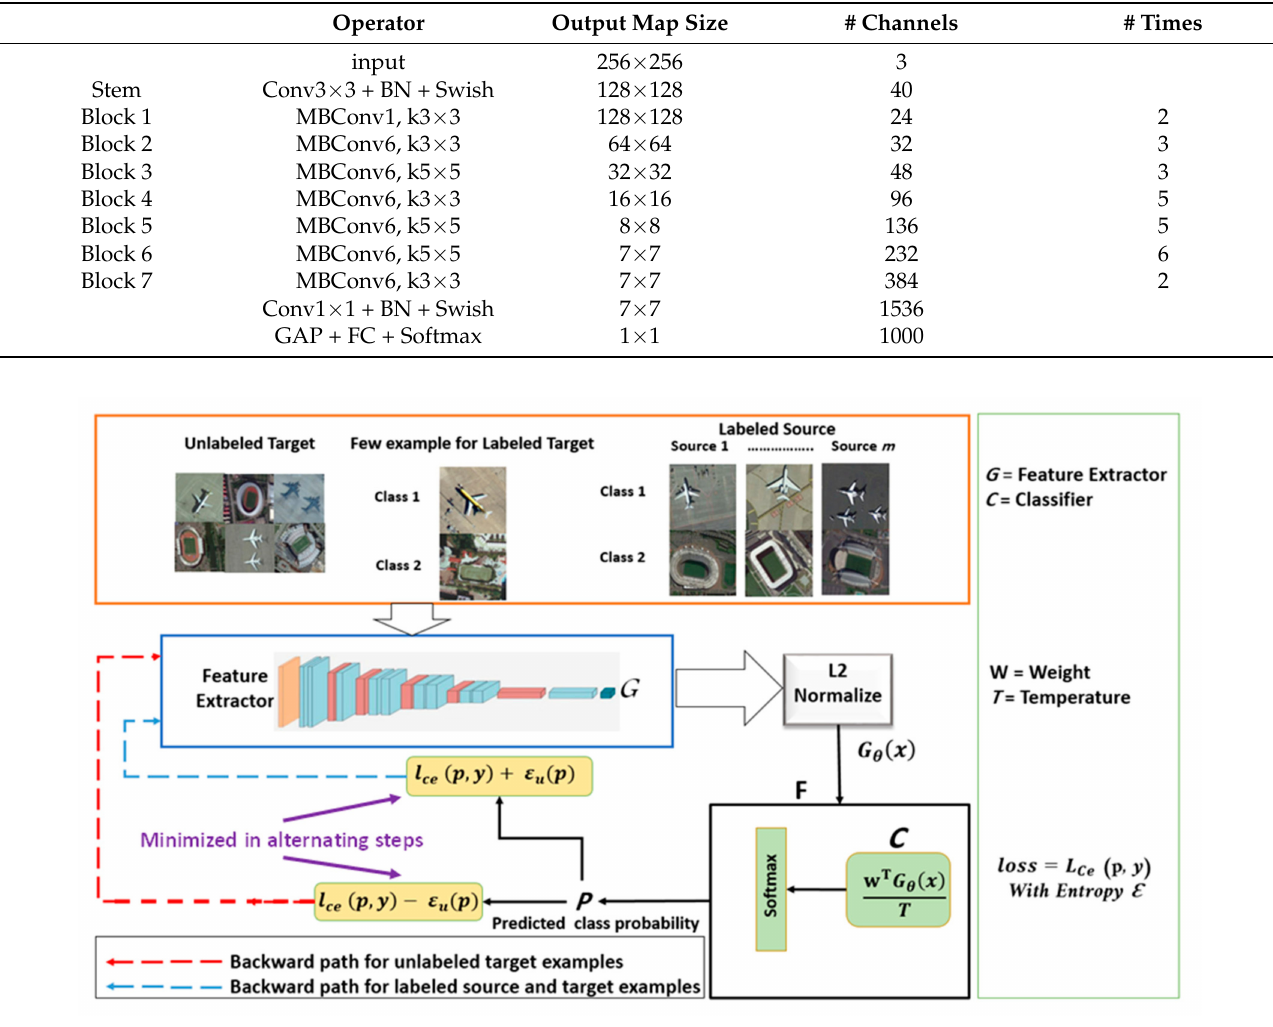
Table 1. Detailed layers and blocks in the EfficientNet-B3 model.